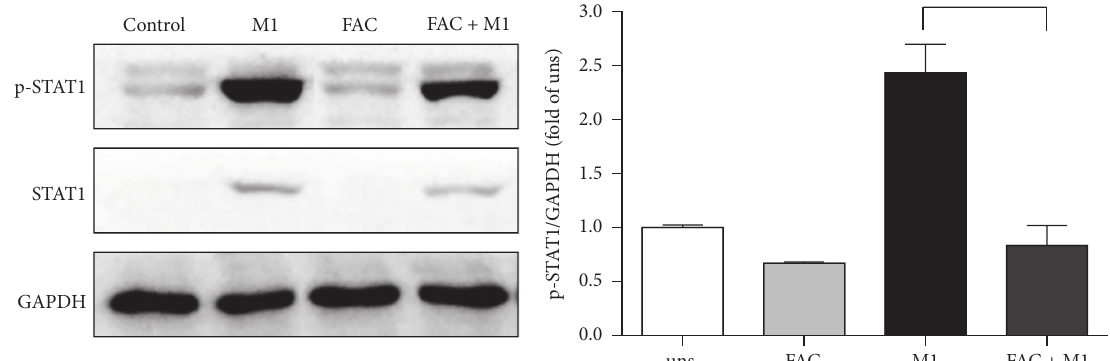
Figure 5: Effect of iron on STAT1 activation in M1 macrophages. RAW264.7 macrophage cells were incubated with the stimulus, either FAC, IFN- 𝛾 , or no stimulus for 24 h. Cell lysates were prepared, and phosphorylation of STAT1 (p-STAT1) was analyzed by western blot. One representative blot and the densitometric quantification are shown. Data are mean ± SD for three independent experiments. (uns: unstimulated macrophages; ∗∗ 𝑝 < 0.01